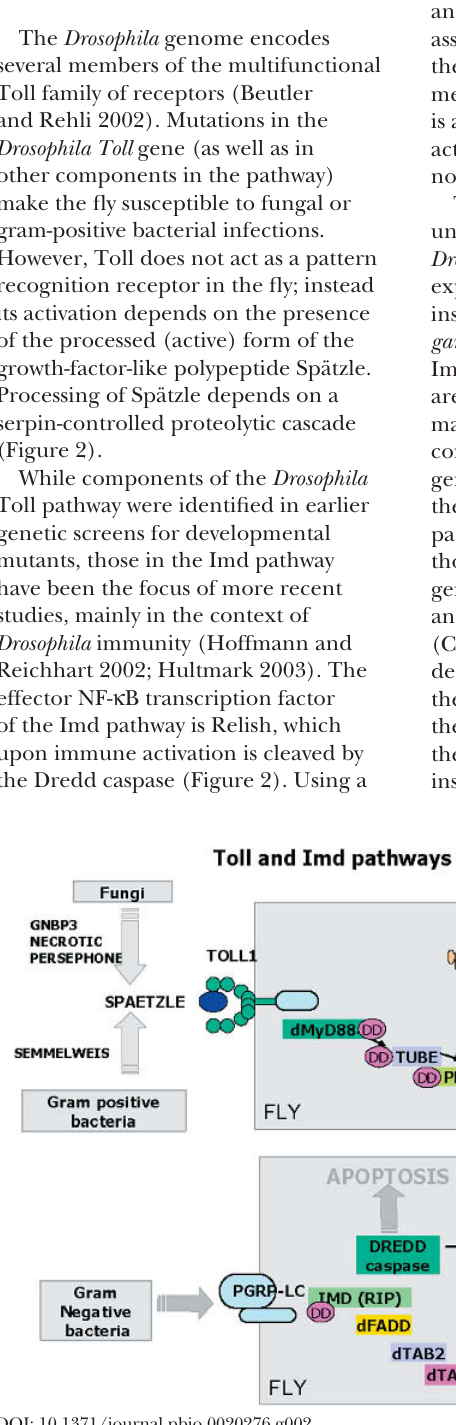
Figure 2. Molecular Components of the Toll and Imd Pathways Involved in Drosophila Immunity Toll is activated by the processed Spätzle (left). Toll activation leads to intracellular signaling via cytoplasmic proteins Tube and Pelle, leading to the degradation of Cactus and nuclear localization of NF-κB proteins Dorsal and Dif. These transcription factors bind to promoters of target genes, such as drosomycin , activating their transcription. The NF-κB protein for the Imd pathway, Relish, activates diptericin transcription. The signaling events resulting in Dorsal/Dif/Relish activation in the fl y are “recycled” in mammals in the activation of mammalian NF-κB. See reviews and De Gregorio et al. (2002) for more